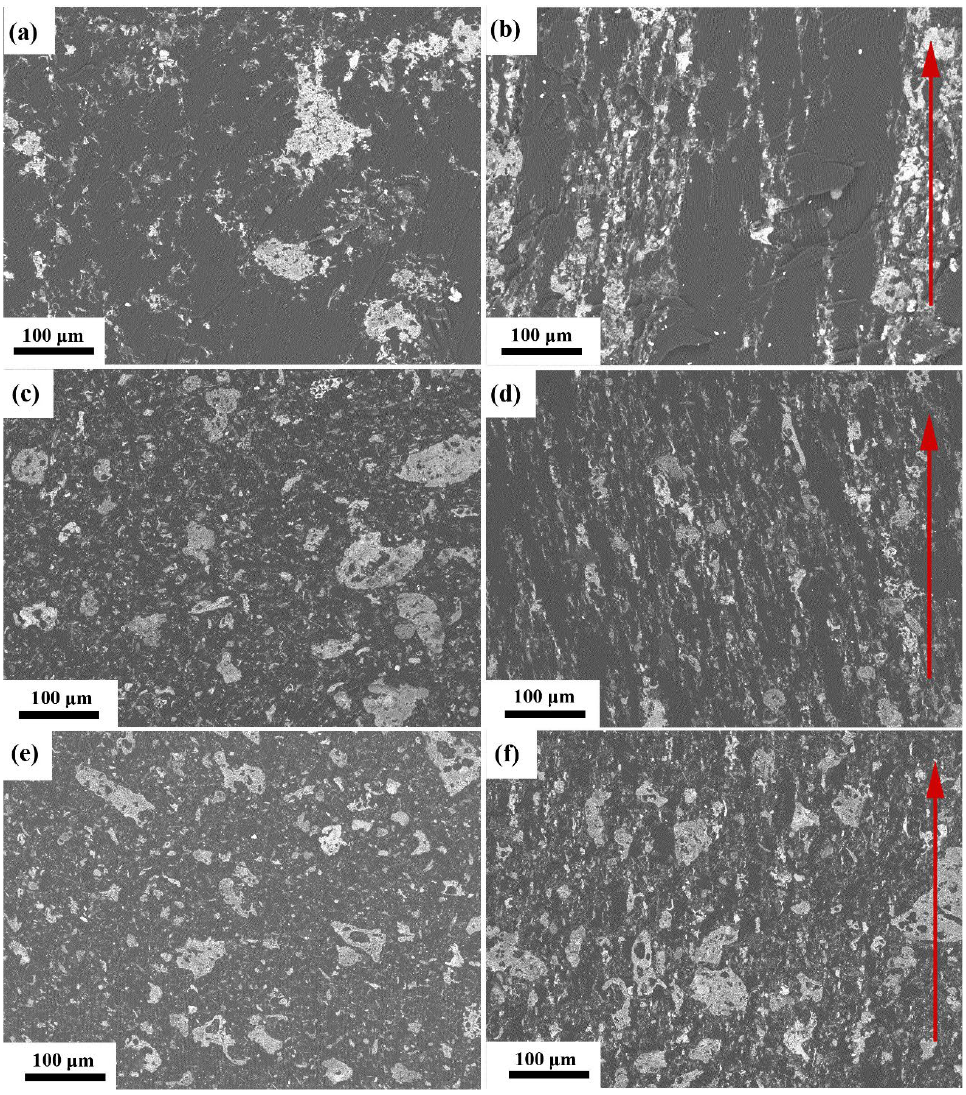
Figure 5. Back-scattering SEM images of the NiGNT-10 ( a ), M-NiGNT-10 ( b ), NiGNT-20 ( c ), M- NiGNT-20 ( d ), NiGNT-30 ( e ), and M-NiGNT-30 ( f ) composites; the red arrows indicate the direction of the magnetic field.